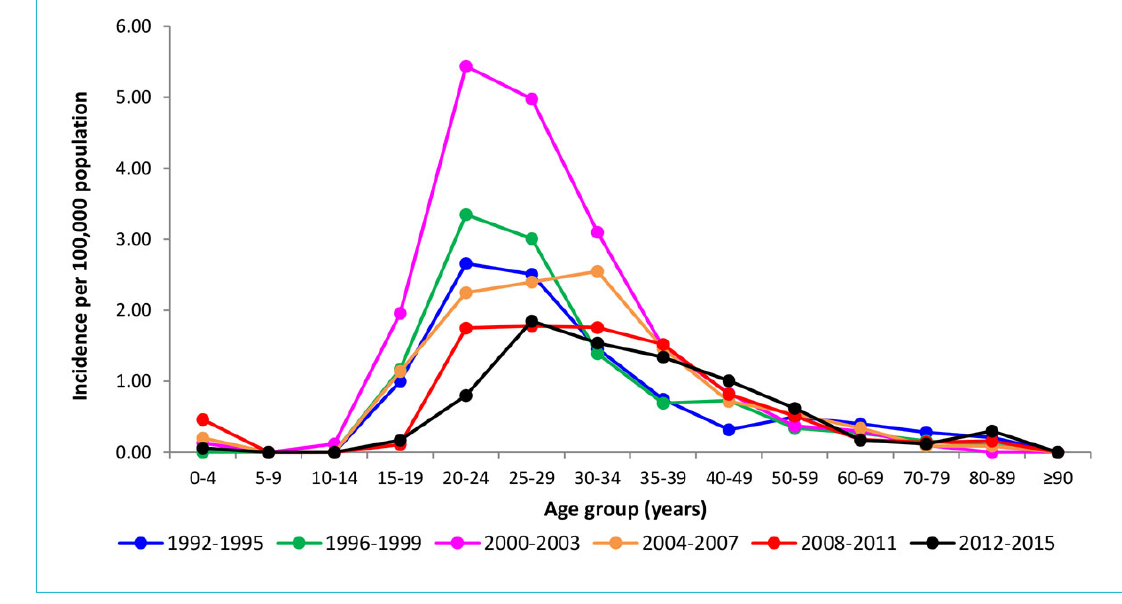
Figure 3: Incidence rates of acute hepatitis C virus cases by age and notification period, Switzerland,